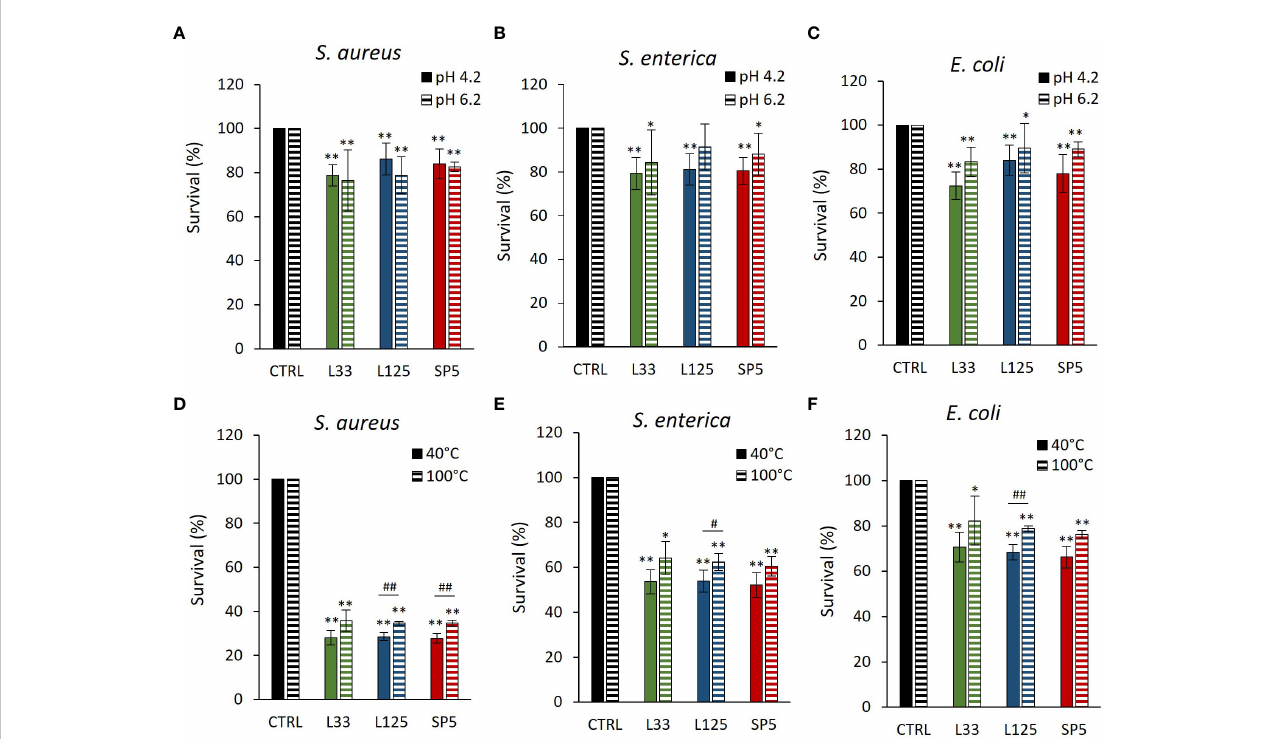
FIGURE 3 Effect of (A – C) pH (4.2, 6.2) and (D – F) heat treatments (40, 100°C) on the activity of the CFCS derived from Lp. plantarum L125, Lp. pentosus L33 and Lc. paracasei SP5 against S. aureus, S. enterica and E. coli after 24 h incubation at 37°C. Viability was determined spectrophotometrically at 620 nm. Data are